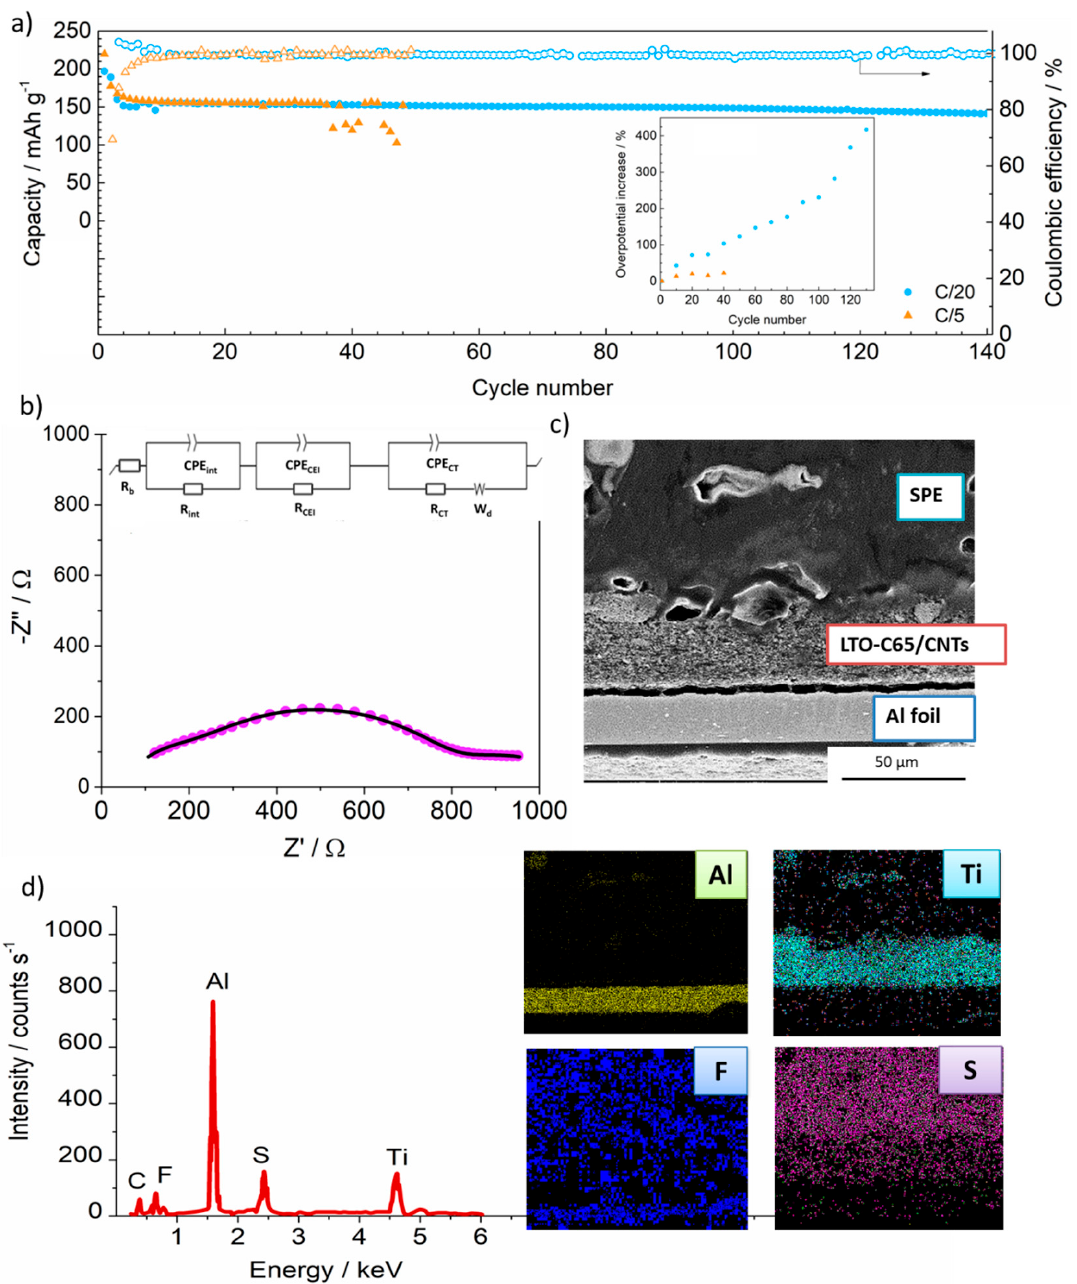
Figure 3. ( a ) Discharge capacity and coulombic efficiency (CE) of the long-term cycling of the LTO-C65/CNTs electrode at C/20 (blue circles) and at C/5 (orange triangles). ( b ) Nyquist-plot of the cell after 140 cycles at C/20 (pink circles) and fitting results of the equivalent circuit (black line) schematized at the top. ( c ) Cross-sectioned micrograph of the bilayer including the SPE and the electrode after 140 cycles and ( d ) EDX mapping of the bilayer thickness area.